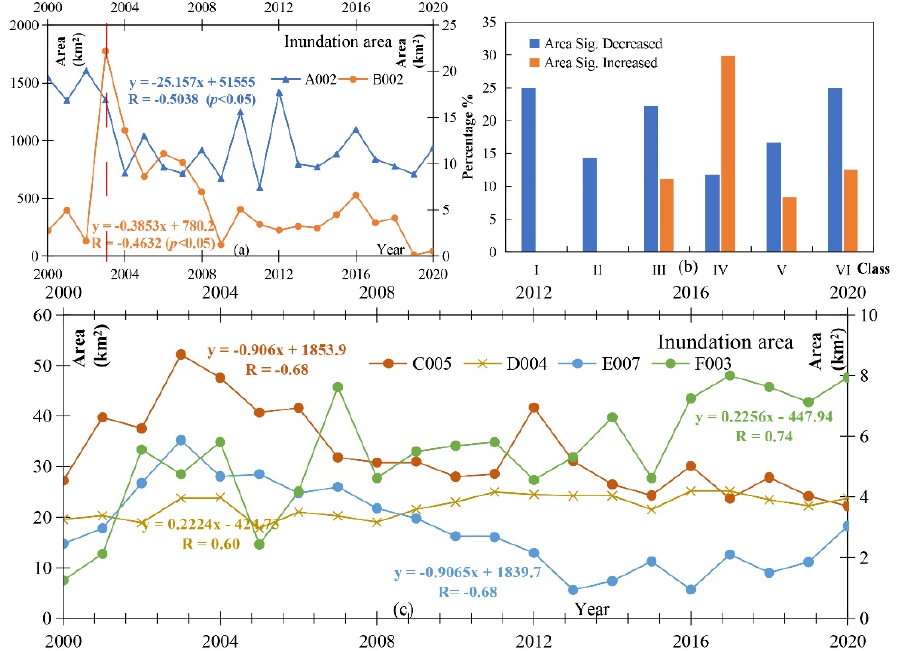
Figure 9. ( a ) Inter-annual inundation area of Poyang (A002) and Douhu Lakes (B002), the B002 was on the sub-axis (right-axis); ( b ) percentages of lakes that exhibited significantly ( p < 0.05) decreasing or increasing trends in inter-annual inundation area for the six different geographical classes; ( c ) inter-annual inundation of lakes in different class: C005, D004, E007, and F003 At the same time, the F003 was on the right-axis. The red dotted line represents the year of 2003 in ( a